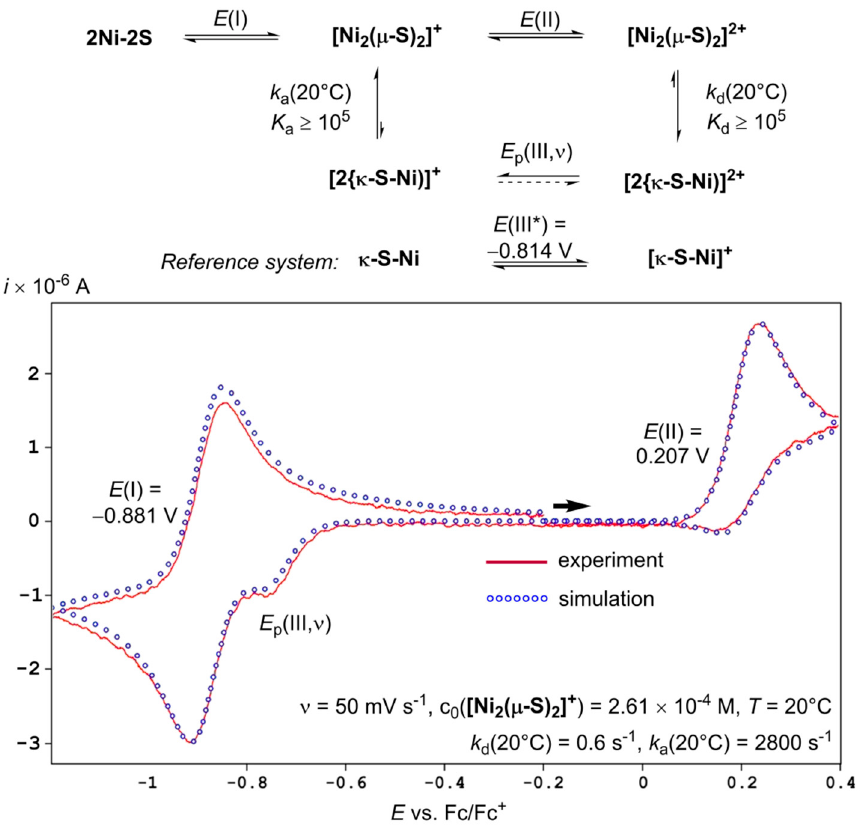
Figure 4. Digital simulation of CV i - E curves based on the extended square scheme depicted at the top; data recorded in 0.1 M n Bu 4 NPF 6 /1,2-C 6 H 4 F 2 solution at a 0.088 cm 2 glassy carbon disc electrode, solid black arrow indicates open circuit potential and initial direction of potential sweep; Fc = ferrocene.